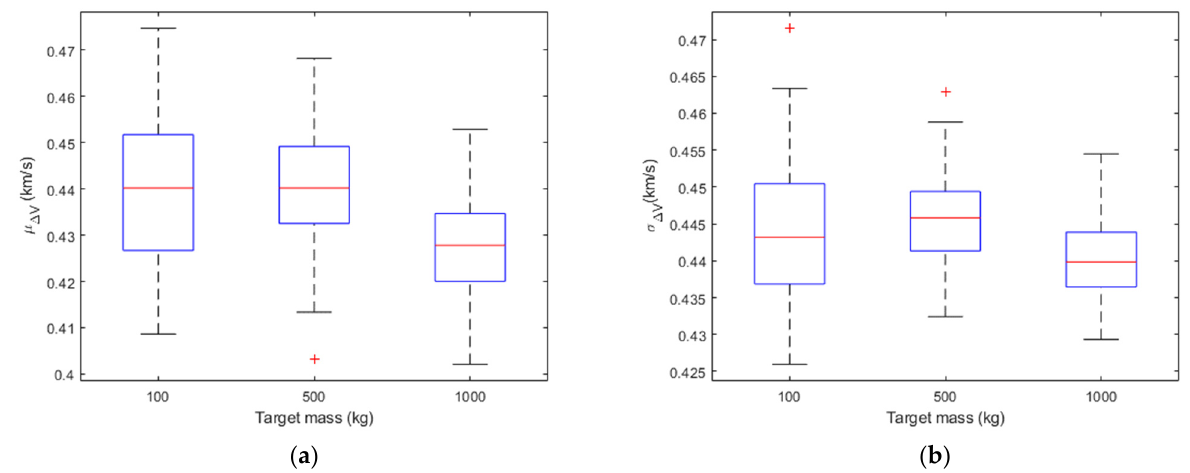
Figure 1. Mean ( a ) and standard deviation ( b ) of velocity distribution of sample fragments for different values of target mass for an impact velocity of 1 km/s. Mass of projectile is assumed to be 100 kg.